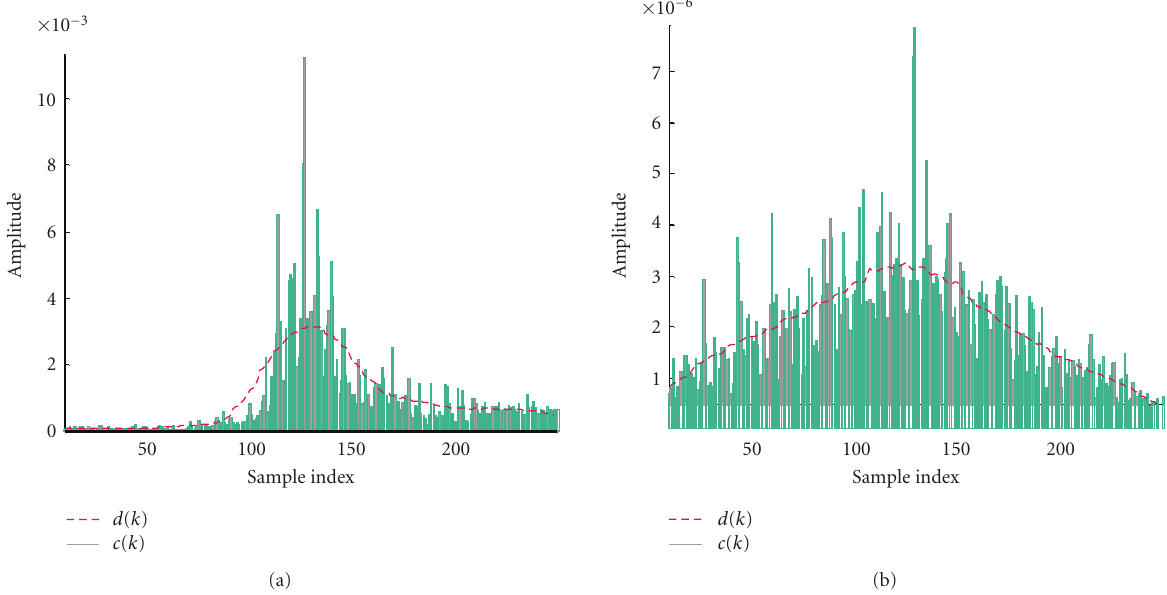
Figure 2: Waveforms of the derived characteristic spectrum. Notice that the E b /N o in simulation is set to 14dB. (a) With the UWB multipath signals plus channel noise. (b) With only channel